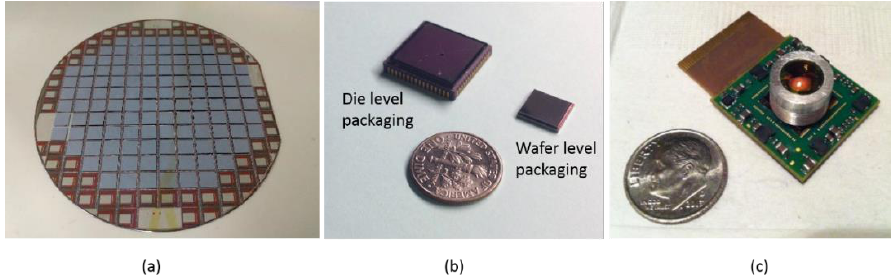
Figure 8. Cu-Sn solid-liquid interdiffusion (SLID) bonding technique used to wafer-level vacuum packaging (WLVP) infrared image sensors. Window wafers with thin film getters and antireflective coatings were bonded to read-out integrated circuit (ROIC) wafers with monolithically integrated microbolometer arrays [103]. ( a ) Photograph of a bonded wafer pair in which window silicon (Si) in the streets between the devices has been removed to allow the devices to be probed at the wafer level; ( b ) Side-by-side comparison of infrared sensors packaged with the die-level and wafer-level packaging approaches; ( c ) Completed WLVP infrared imaging system.